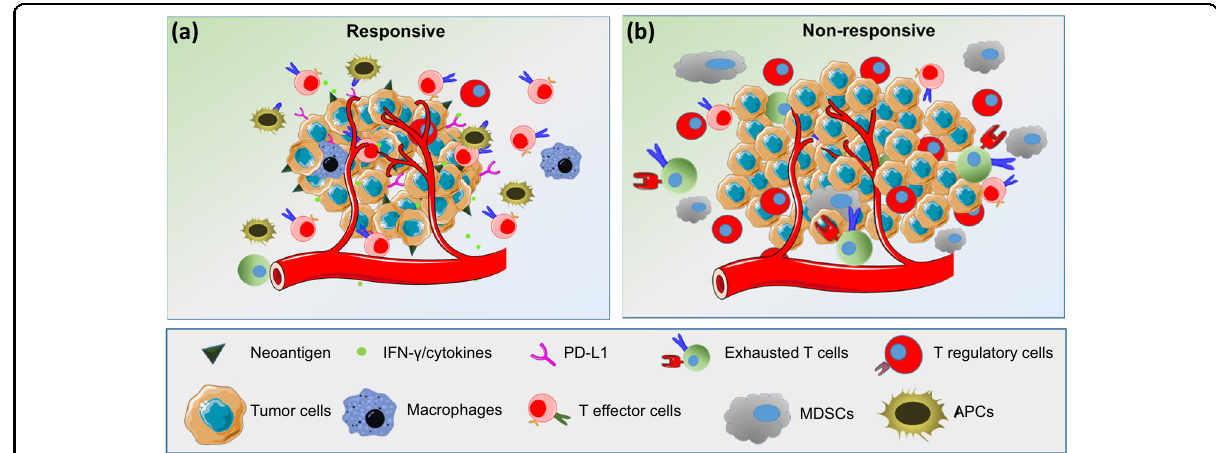
Fig. 1 Overview of predictive biomarkers for response to ICIs. The response to immune checkpoint inhibitors varies depending on the TME. In the responders, tumors have a high neoantigen load, high levels of TILs, especially effector cells, a high Teff to Treg ratio, low MDSC levels and increased secretion of IFN- γ and other cytokines ( a ). In nonresponders, the TME contains high levels of immunosuppressive cells, such as Tregs and MDSCs, and very low levels of NK cells and activated lymphocytes ( b )